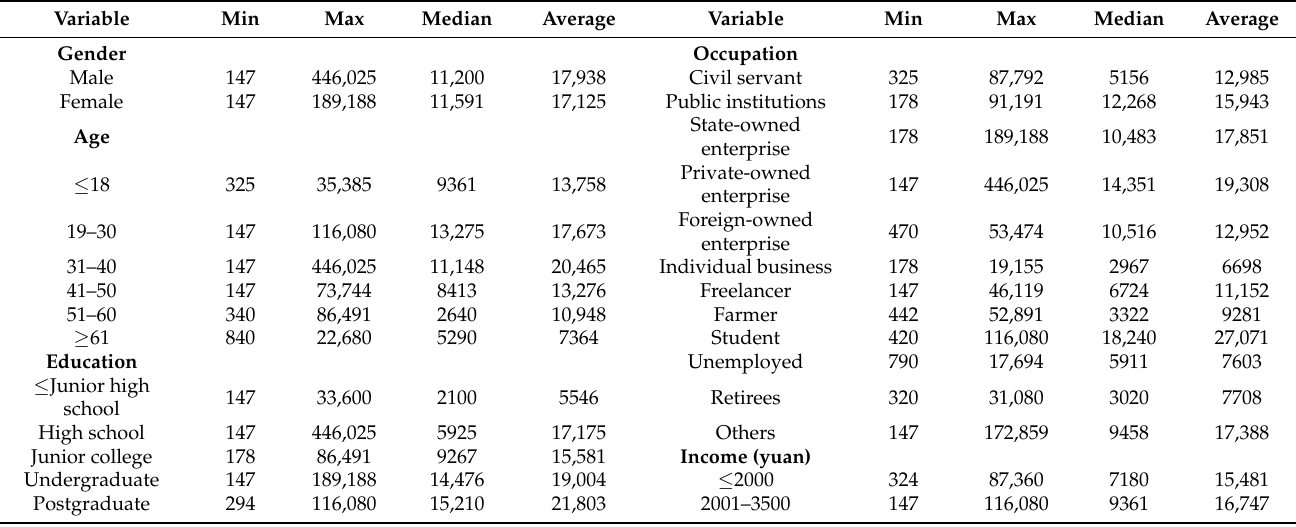
Table 5. Exposure risk level of different social